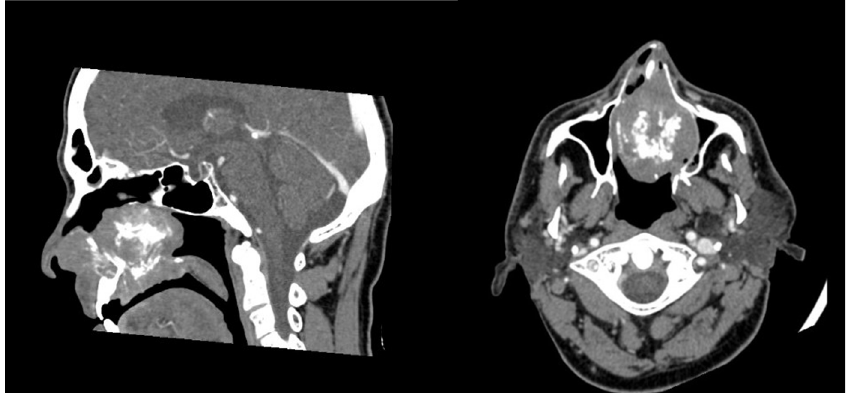
Fig. 3. High Resolution Computed Tomography (HRCT) scan of paranasal sinuses showing a large mass measuring 6cm in the nasal cavity in axial and sagittal